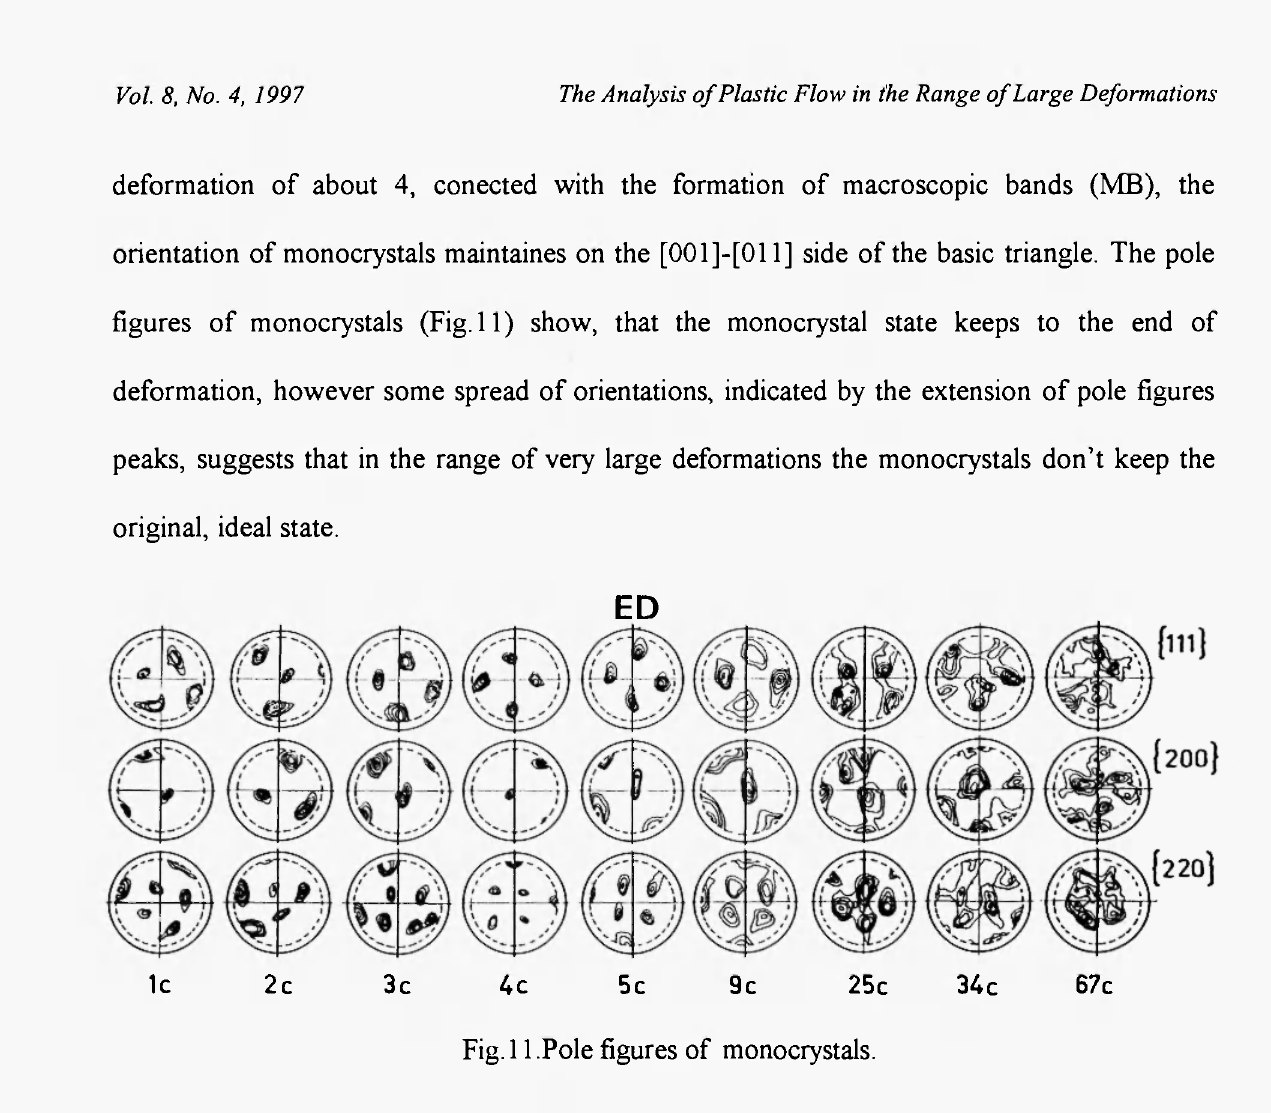
Fig. 11 Pole figures of